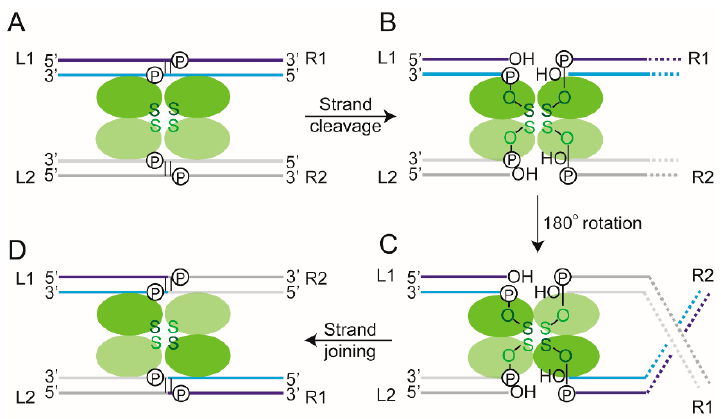
Figure 2. Serine site-specific recombination. ( A ) During serine recombination, the two core target sites (each bound by a recombinase dimer) are brought together in an activated synapse. The dimers bound to the two sites are distinguished by coloring them in different shades of green. The green color indicates the chemically competent state of all four recombinase monomers. In the case of tyrosine recombination (shown in Figure 3), only two of the four recombinase monomers are in the ‘active’ state at a time. The two partner sites are colored differently to better illustrate the DNA rearrangement resulting from recombination. Within a DNA site, the two strands (‘top’ and ‘bottom’) are shaded dark and light, respectively. ( B ) The scissile phosphodiester bonds on the two strands (separated by 2 bp; marked ‘P’) are then cleaved in both partner sites. The recombinase gets attached to one end of the cleaved strand by a 5 ′ -phosphoserine linkage. The adjacent DNA end carries a 3 ′ -hydroxyl group. ( C ) The cleaved complex undergoes a 180° rotation, and is aligned in the recombinant partner configuration. The rotation between the cleavage and joining steps can be appreciated by the DNA crossing introduced as a result. The dashed lines represent DNA flanking the target sites to the right. ( D ) Strand joining by a chemical reversal of the cleavage step completes a round of recombination. In ( A – D ), the left to right orientations of the partner sites are indicated as L1-R1 and L2-R2 (before recombination), and as L1-R2 and L2-R1 (after recombination). They are arranged in a parallel fashion, that is, directed the same way in the plane of the synapse. For simplicity, the figure omits accessory sites and the DNA–protein interactions occurring at such sites, which are essential for reaction by some of the serine recombinases. The color schemes for DNA strands and protein subunits are kept the same in Figures 3 and 9, depicting schematics of recombination reactions.